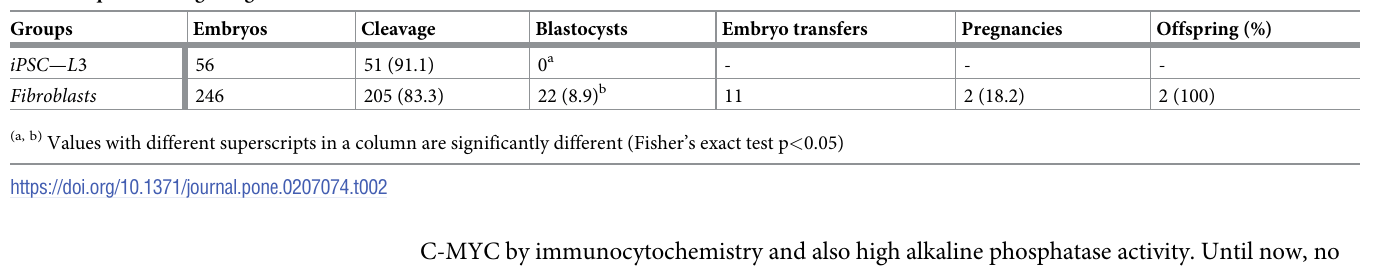
PLOS ONE | https://doi.org/10.1371/journal.pone.0207074 December3,